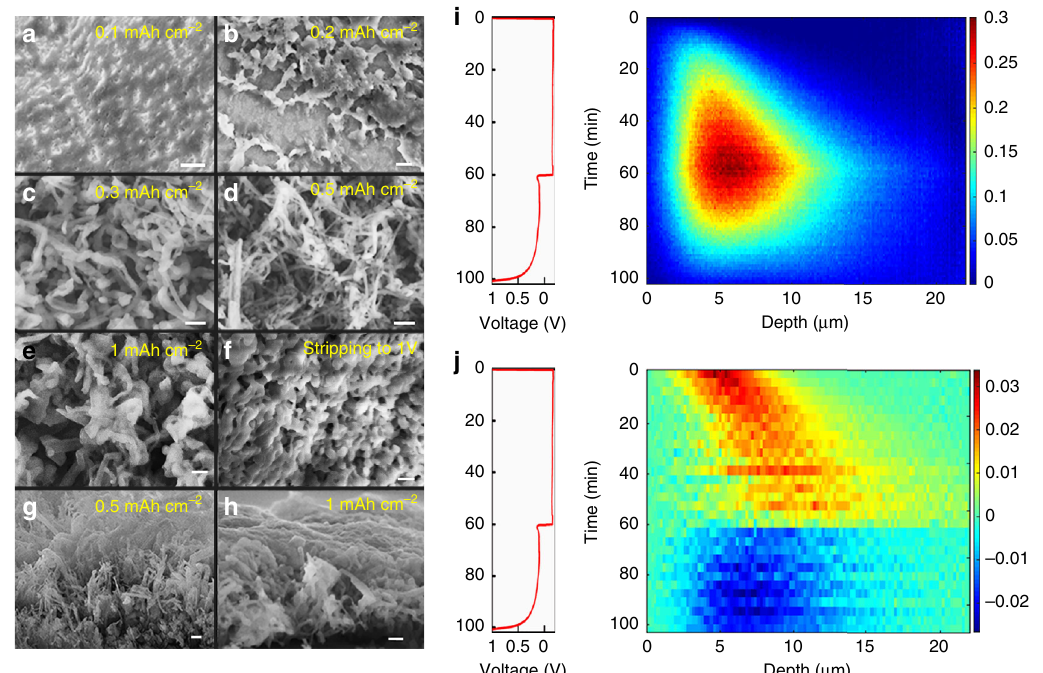
Fig. 2 Li density and Li-metal-plating/stripping activity by operando NDP compared with ex situ SEM. a-h SEM measurement showing the 1 mA cm – 2 Li- plated metal morphology at a 0.1, b 0.2, c 0.3, d 0.5, and e 1 mAh cm − 2 and f after stripping. g , h Cross sections are shown for 0.5 and 1 mAh cm − 2 . The scale bar in a – b is 5 μ m and in c – h it is 1 μ m. i Displays the Li density vs. time from operando NDP during the fi rst plating and stripping cycle at 1 mAh cm – 2 and j the Li-plating and stripping activity, which is derived from the change in Li density upon each time step in i . In i and j the depth is measured starting from the interface of the Cu current collector with the